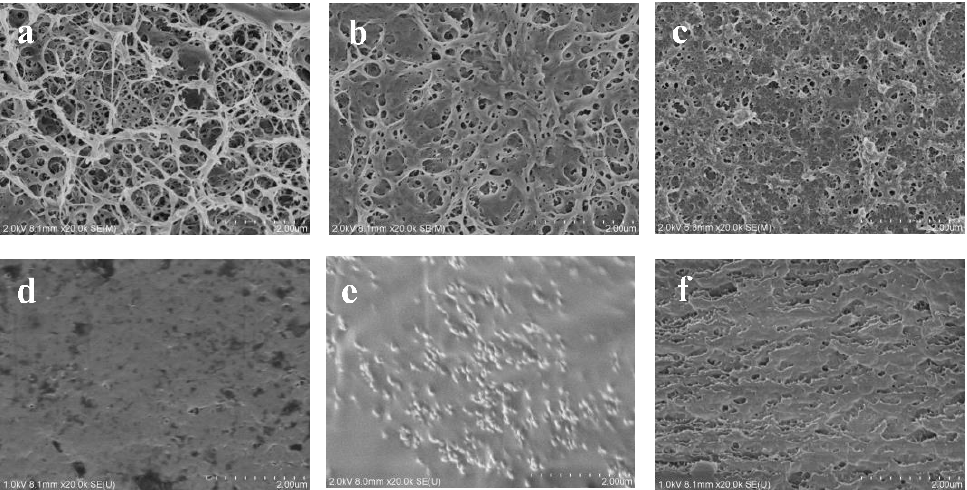
Figure 2. SEM images of the RC membrane: ( a ) surface, ( d ) cross-section; TORC membrane: ( b ) surface, ( e ) cross-section; PEI-TORC membrane: ( c ) surface, ( f ) cross-section. As shown in Figure 3, the mechanical properties of the modified membranes were reduced.